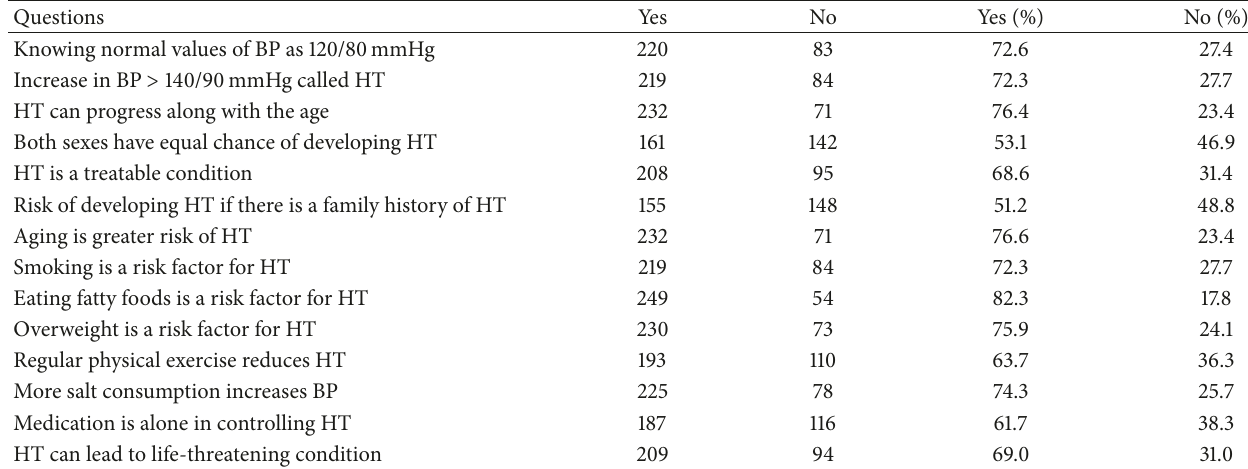
Table 2: Patient’s knowledge of hypertension.